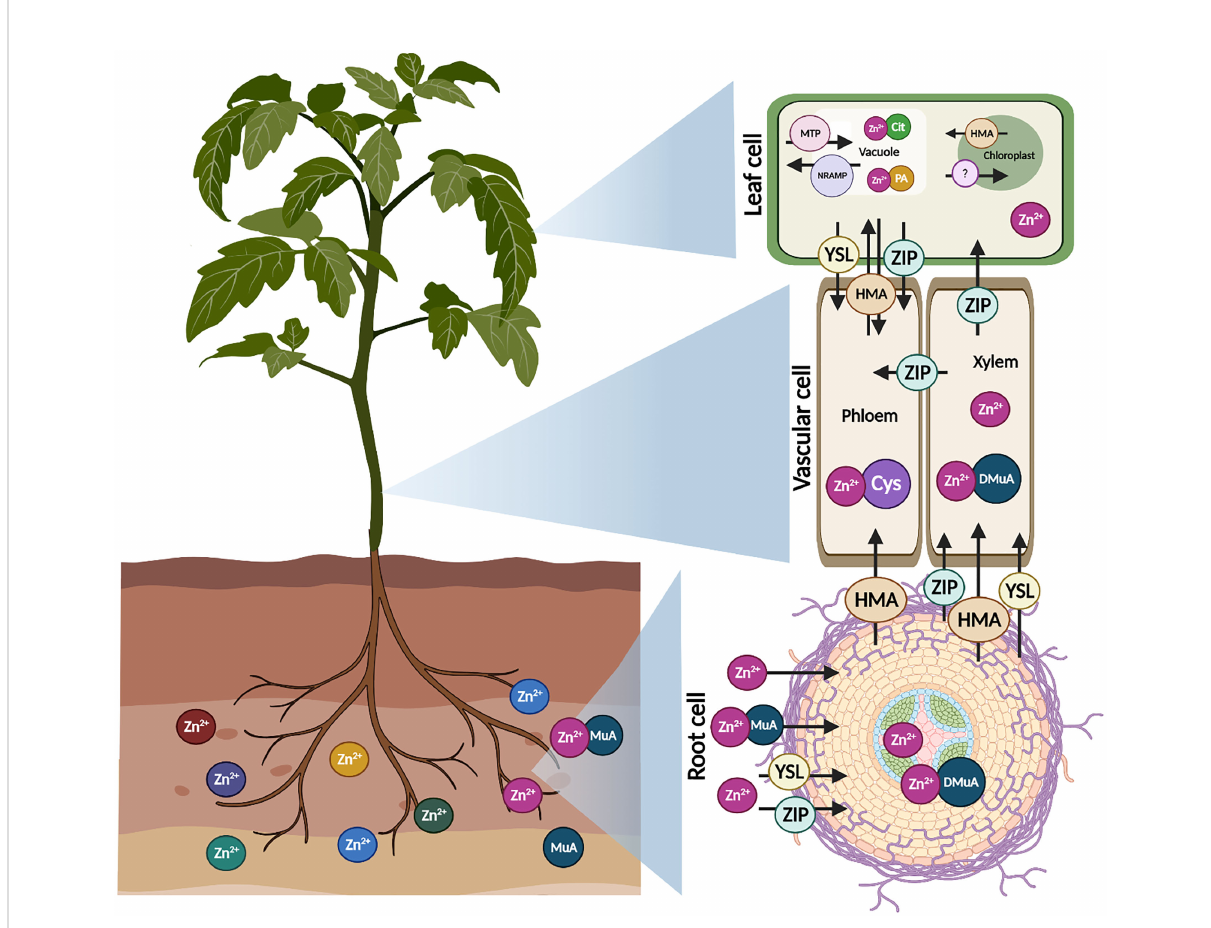
FIGURE 2 Mechanism of Zn transport in plants. Zn in soils penetrates in roots as Zn 2+ or in a combination with mugineic acid (MuA), mediated by various transporter families such as yellow stripe like (YSL) and zinc regulated transporter (ZIP). Zn is either translocated as Zn 2+ ion or as Zn complexes with MuA. Further, Zn interacts with 20-deoxymugineic acid (DMuA) promoting intercellular stability. Some transporters such as heavy metal ATPases (HMA), natural resistance-associated macrophage protein (NRAMP) and metal tolerance proteins (MTP) are present on the plasma membranes of cell and transport Zn to other parts of the plant cell. In phloem, Zn chelated with cysteine (Cys) participates in Zn sequestration. Chelated or free Zn 2+ absorbed and mobilized in leaf vacuole and chloroplast. MTP transporter family required in the Zn sequestration. HMA and NRAMP transporters are capable of transferring accumulated Zn from leaf vacuole and chloroplast back into cytoplasm from loading into phloem during mobilization. Zn is chelated with citrate (Cit) and phytic acid (PA) in leaf